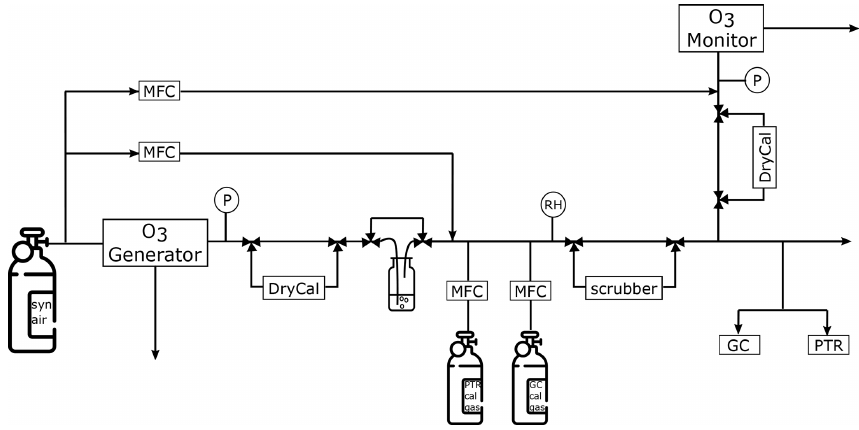
Table 1. Conditions of the different experiments performed in this study. Condition O 3 levels (ppb) CalGas MR (ppb) RH (%) Effect of O 3 on VOCs 0, 50, 1000 0, 0.5, 1, 2, 4 0 Effect of O 3 on tubing 0, 25, 50, 100, 150, 400, 750, 1000 0, 0.5 0 Effect of RH on VOCs with and without scrubber 0, 50, 150 0, 0.5, 2 0, 50, 80 Scrubber endurance 50, 150, 1000 0 0,